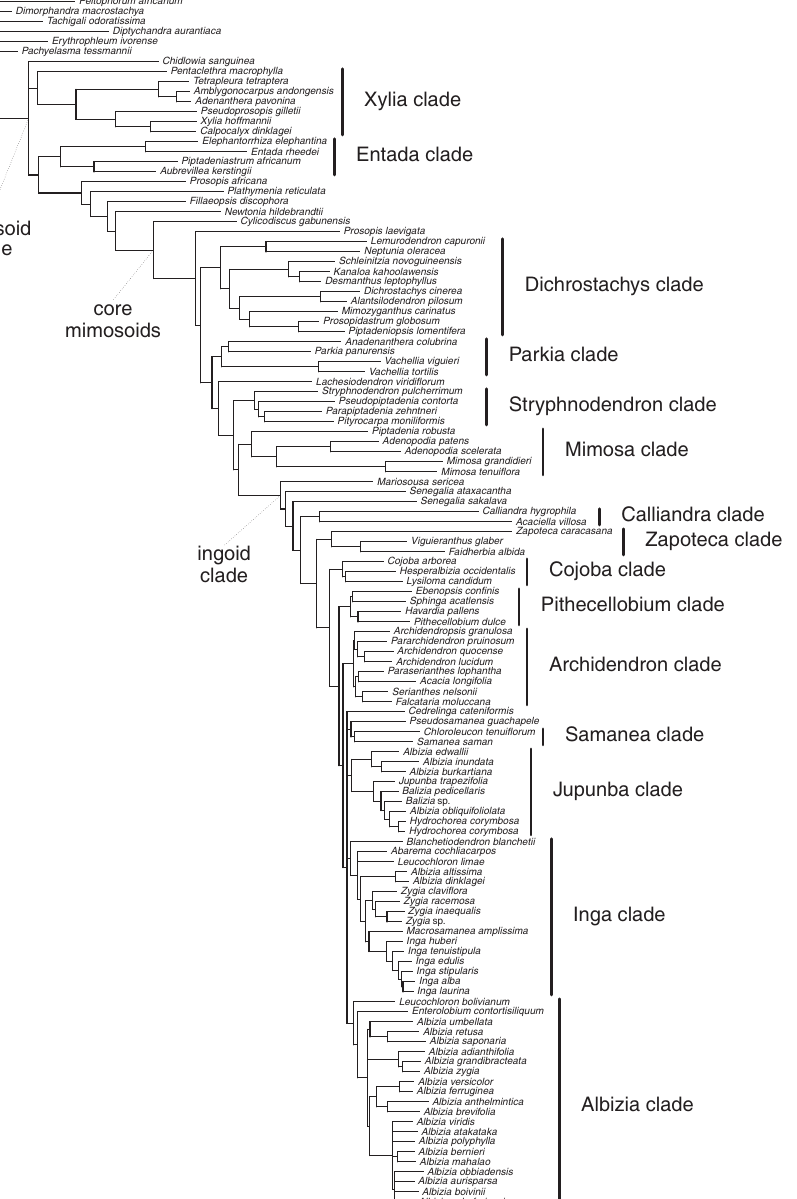
Figure 1. Phylogeny of Caesalpinioideae with clade names as inferred by Koenen et al. (2020b), the starting point for this